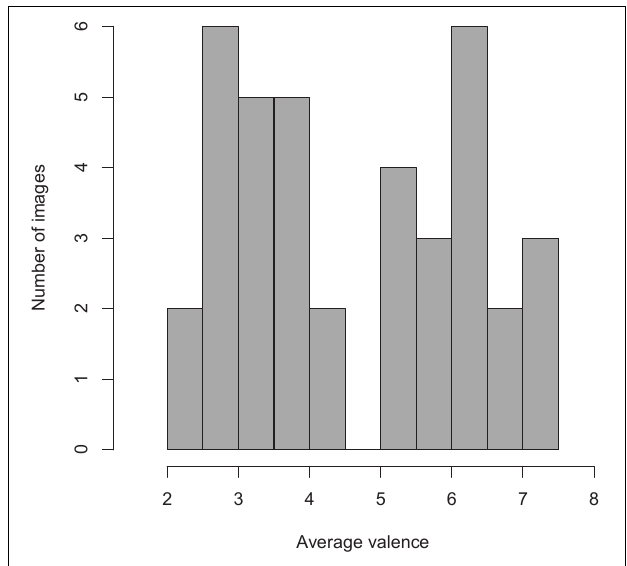
FIGURE 1 | Histogram showing the distribution of mean self-ratings of valence for the 38 images from the IAPS used in the present study. Visual inspection led to dividing the images into high and low valence groups with a split at the rating 5.